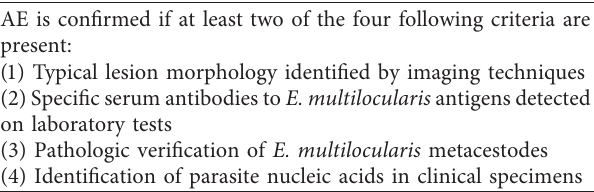
Table 2: Diagnostic criteria for AE [10]. AE is confirmed if at least two of the four following criteria are